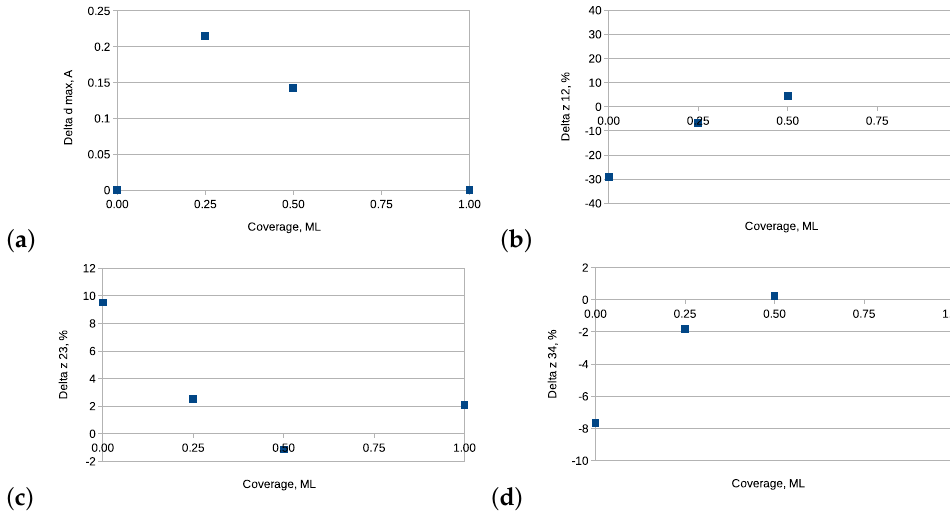
Figure 9. ( a ) Buckling of the topmost nitrogen monolayer, constituted based on the on top site. Relaxations of the topmost three interlayer spacings on the GaN ( 000¯1 ) surfaces vs. C coverage. ( b ) ∆ z 12 . ( c ) ∆ z 23 . ( d ) ∆ z 34